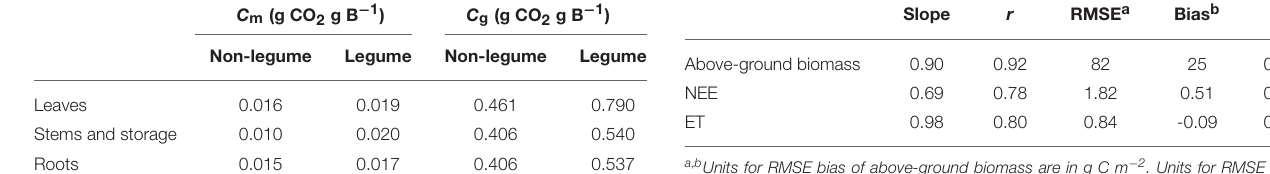
TABLE 2 | Coefficients of maintenance respiration ( C m ) and growth respiration ( C g ) of vegetative organs at a temperature of 20 ◦ C (adapted from Penning de Vries et al., 1989).